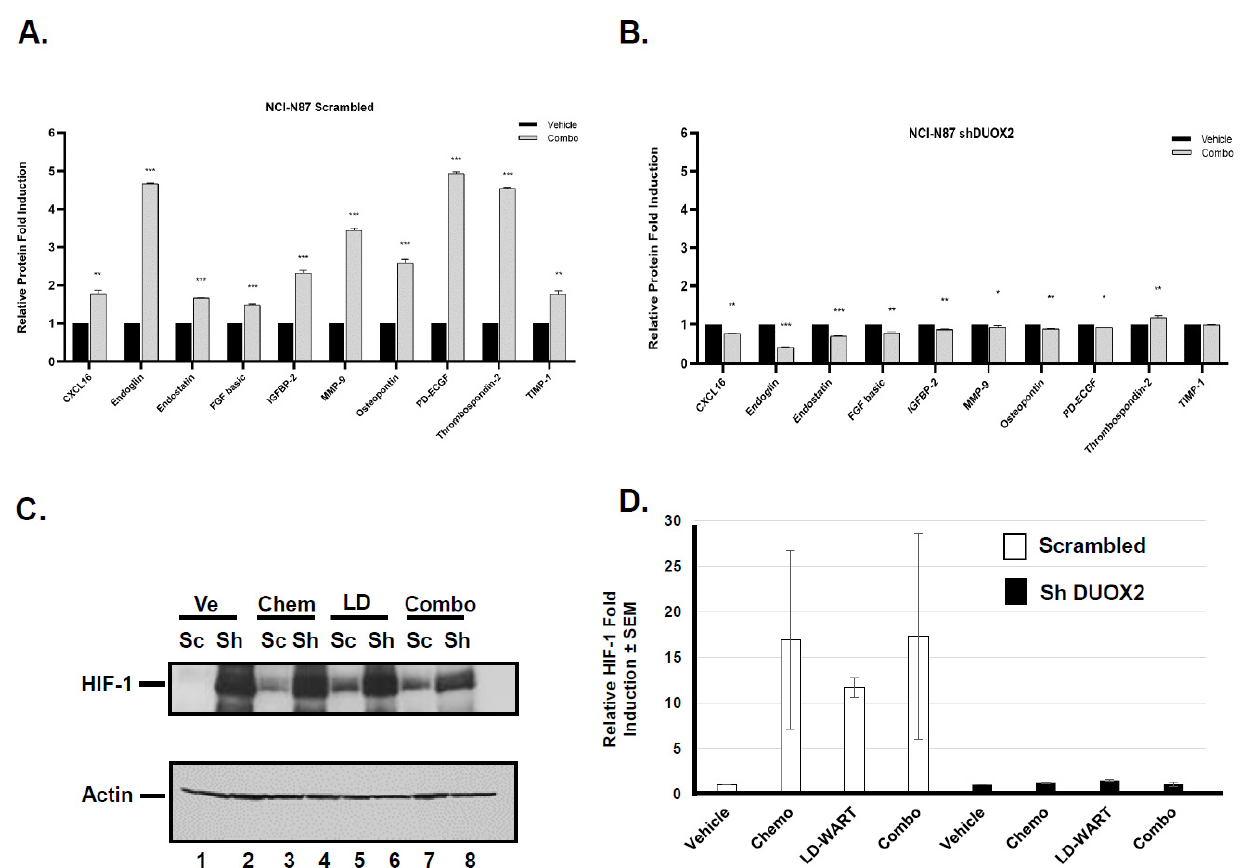
Figure 4. Effect of combined regimen of mDCF and LD-WART on angiogenesis and HIF-1 in vivo. ( A ) Mouse angiogenesis profiler array performed on tumors expressing endogenous DUOX2 levels. Three to four tumors of each treatment groups were pooled and analyzed as described in Material and Methods. Data are presented as fold induction of respective control (Vehicle) after background subtraction ± SD. ( B ) Same as ( A ) except that proteins were extracted from DUOX2 negative tumors (shDUOX2). Statistical analyses were performed by one-way analysis of variance (ANOVA) using GraphPad Prism 6.0 software. * p < 0.05, ** p < 0.01, *** p < 0.001. p < 0.05 was considered significant. ( C ) Western blot of HIF-1 protein extracted from tumors expressing endogenous (Sc = scrambled) or reduced (Sh-shDUOX2) levels. Actin was used as loading control. Ve = Vehicle, Chem = chemotherapy (mDCF), LD = LD-WART, Combo = mDCF + LD-WART. ( D ) Quantitation of HIF-1 Western blots expressed as fold induction after normalization to Actin and respective untreated (Vehicle) control.